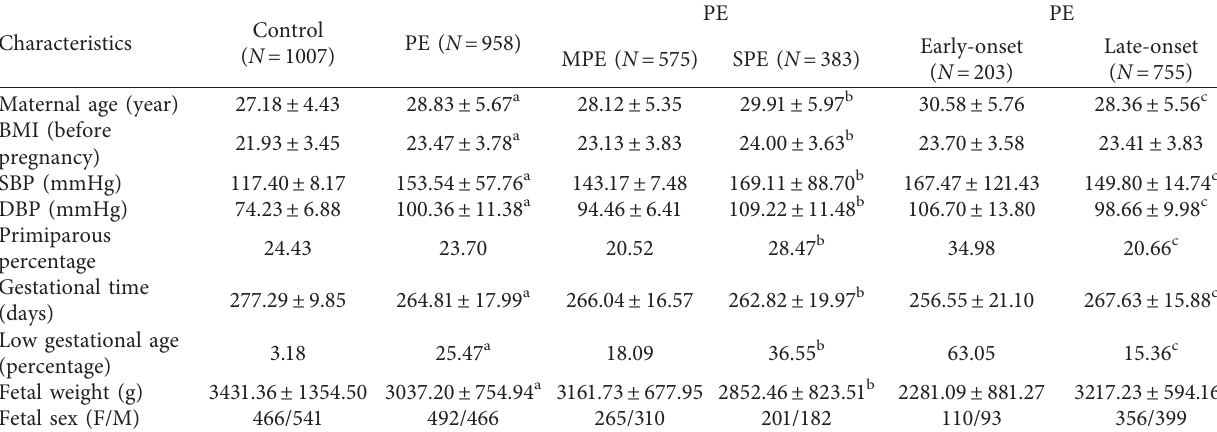
Table 1: Clinicopathological characteristics of subjects (mean ± SD).